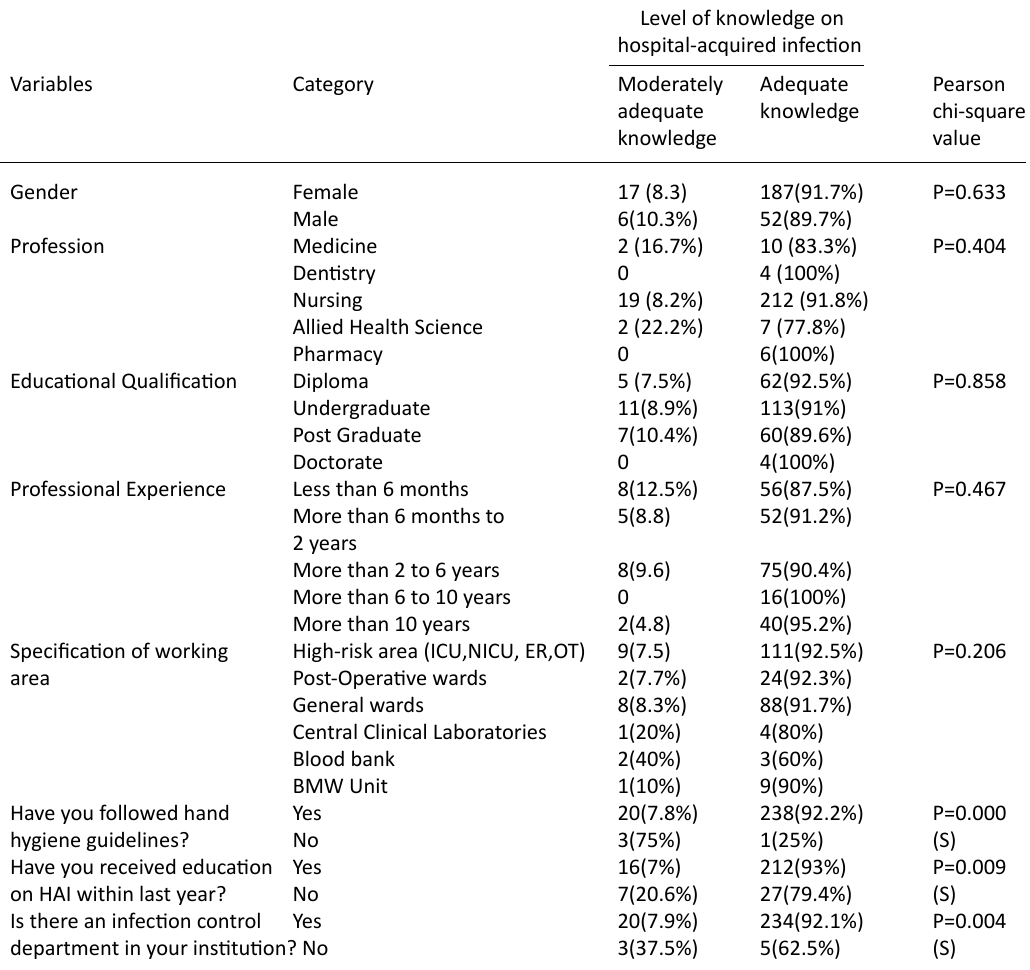
Table 7. Association between the level of knowledge and demographic variables (n =